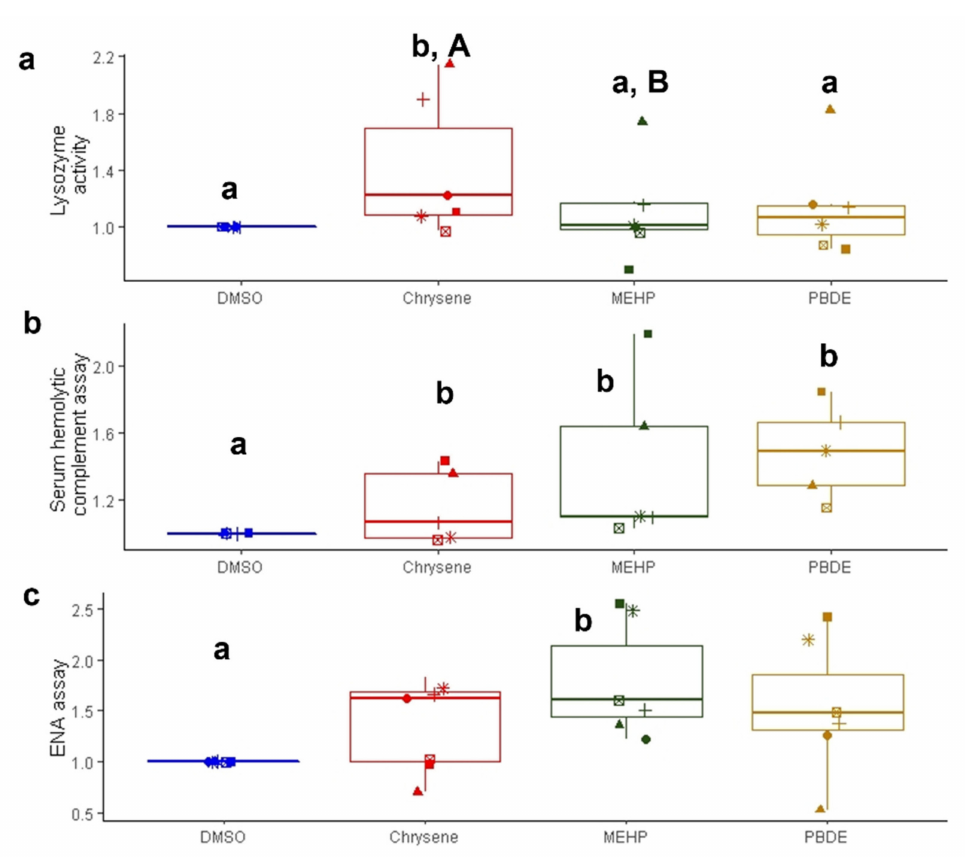
Figure 6. Lysozyme activity, serum hemolytic complement assay, and ENA assay: box plot of lysozyme activity ( a ), serum hemolytic complement assay ( b ), and ENA assay ( c ) detected in blood samples of seven Caretta caretta specimens. DMSO, chrysene, MEHP, and PBDE-47 groups are represented in blue, red, green, and yellow, respectively. The paired samples (same animal) are indicated with different symbols across the treatments. Individual values are normalized on the control (DMSO) value of each animal merely to improve the visualization of the results, as properly detailed in the Material and Methods section. Different normal lowercase (e.g. a and b) indicate significant differences with respect to control ( p < 0.05); different uppercase letters (e.g. A and B) indicate differences among the